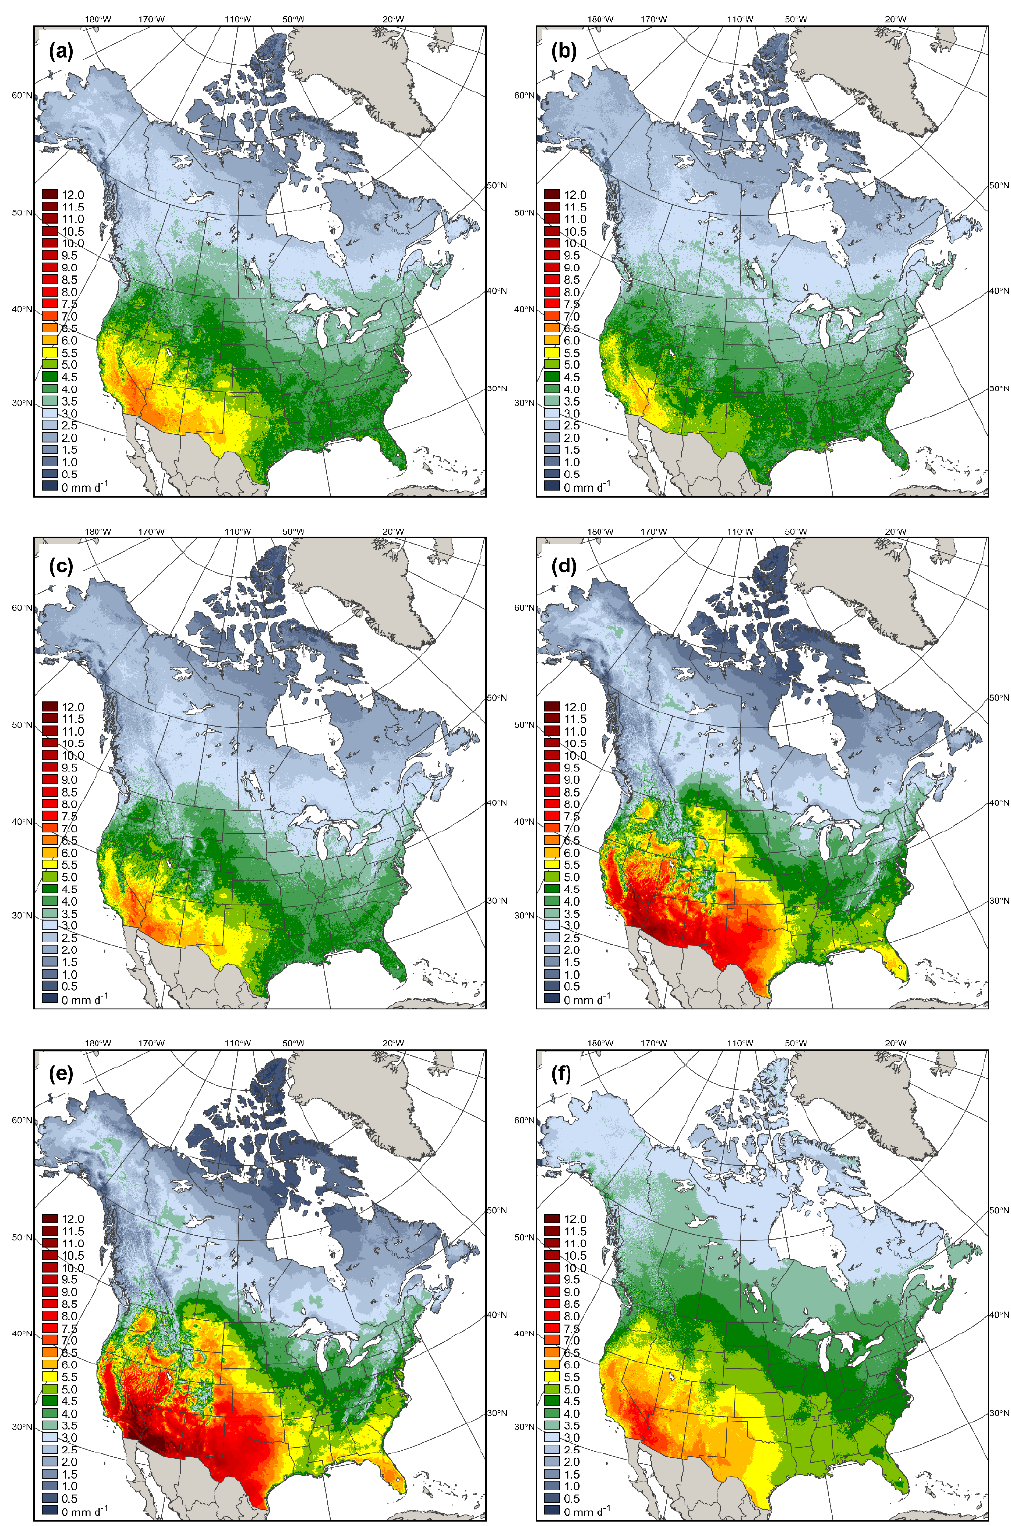
Figure 6. Comparison between long-term (1971–2000) mean daily potential evaporation (PE) over the warm season (May–September). Units of PE are expressed as mm · day − 1 : ( a ) Penman’s model ( E Pen ); ( b ) Priestley–Taylor model ( E PT ); ( c ) reference grassland ( E RG ) based on the Penman–Monteith model; ( d ) reference forest with moderately coupled canopy ( E RFu ) based on the Penman–Monteith model; ( e ) reference forest with coupled canopy ( E RFc ) based on the Penman–Monteith model; ( f ) linear mixed-effects model fit to monthly mean pan evaporation ( E PanFit